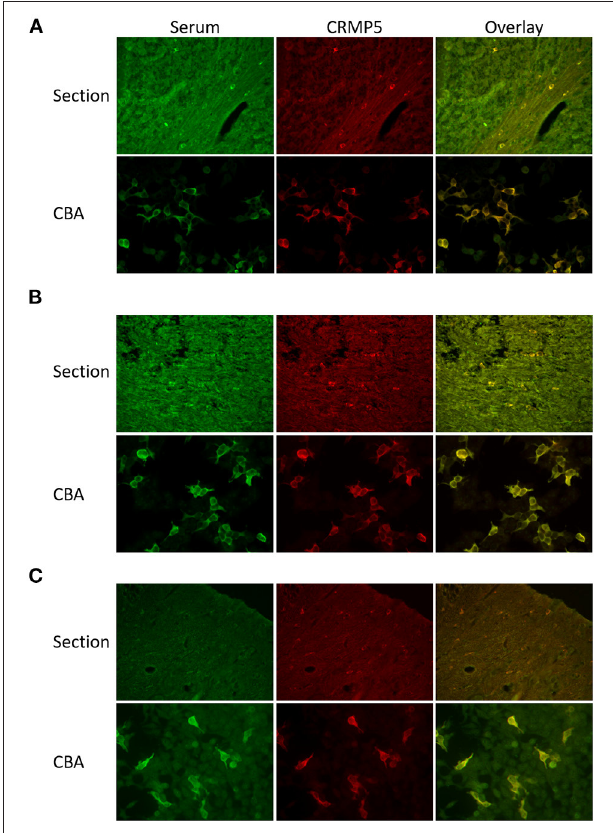
FIGURE 1 | Comparison of CRMP5 staining patterns in cerebellar sections and CRMP5-CBA. (A) Section: Serum from a patient with thymoma and myasthenia gravis stains oligodendrocytes in cerebellar white matter (green). A rabbit anti-CRMP5 antibody (red) stains the same cells. Overlay seen in yellow. CBA: Patient serum (green) specifically detect CRMP5-transfekted HEK293 cells. Anti-CRMP5 antibody (red) is used to detect CRMP5 positive cells. Overlay seen in yellow. (B) Section: Serum from a patient with peripheral neuropathy, lung cancer, Hu, Zic4, and CRMP5 antibodies. The CRMP5 signal is masked in the additional staining of the other antibodies in the patient serum (green). Co-staining with rabbit anti-CRMP5 antibody (red). The overlay shows that the serum also detects CRMP5 positive oligodendrocytes. CBA: The serum (green) stains CRMP5 positive cells in the CRMP5-CBA. Rabbit anti-CRMP5 (red) is used to verify CRMP5 positive cells. Overlay seen in yellow. (C) Serum from a patient with lung cancer and peripheral neuropathy (green) is negative in cerebellar